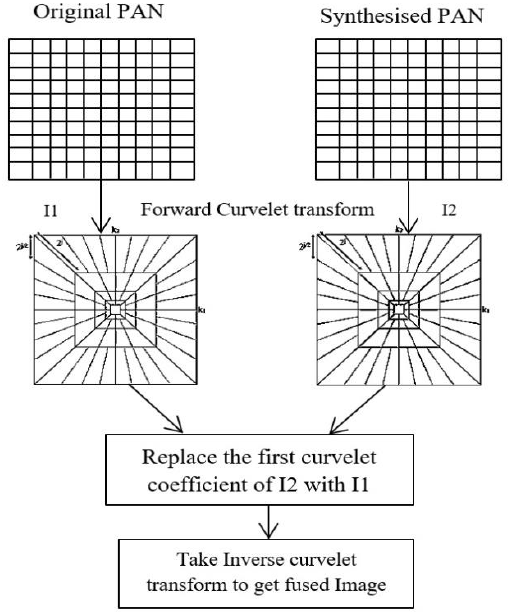
Figure 3: Curvelet based Fusion For improving spatial